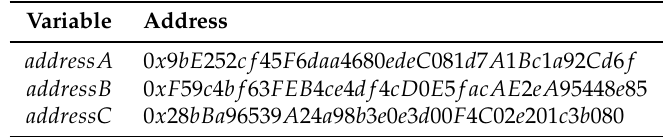
Figure 5. Experiment Environment. Table 2. Ethereum Addresses of the